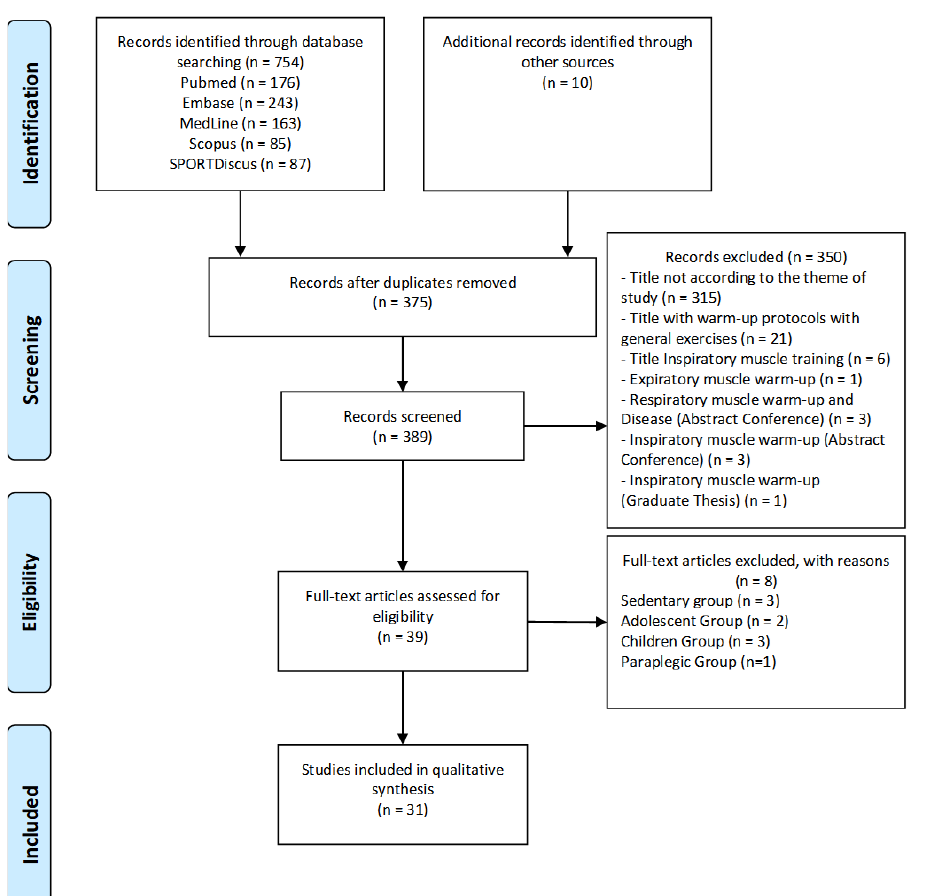
Figure 1. Flow diagram of the study’s screening process.